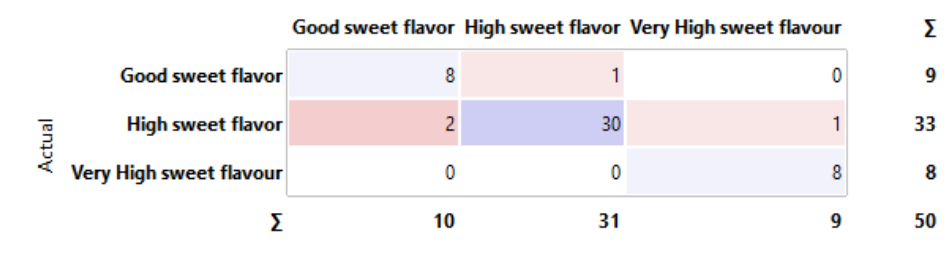
Figure 6. The prediction values of the different algorithms.